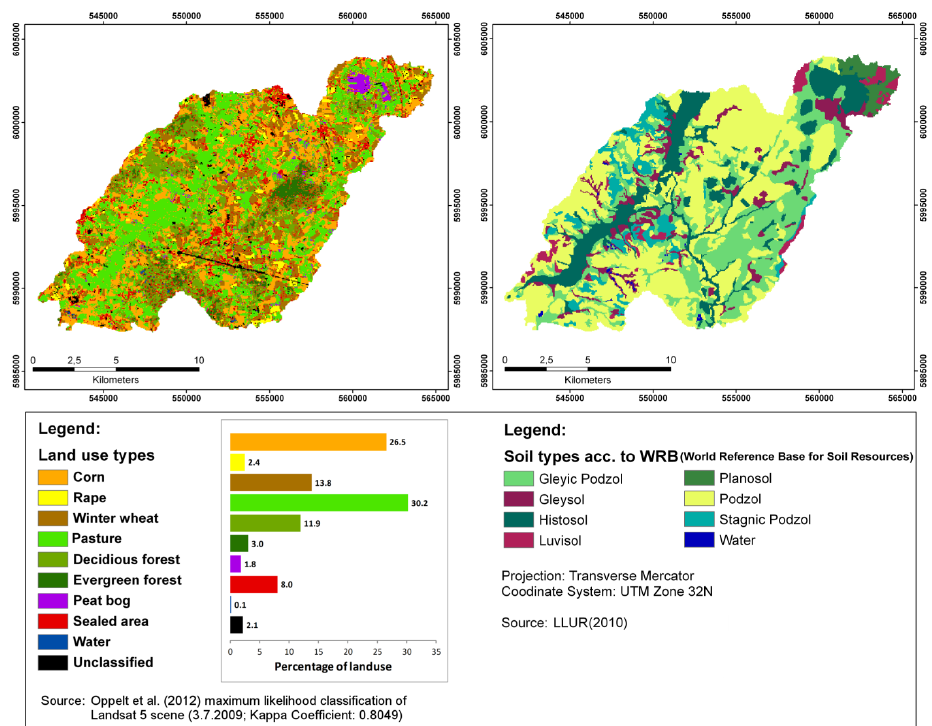
Fig. 2. Land use and soil types in the B¨unzau